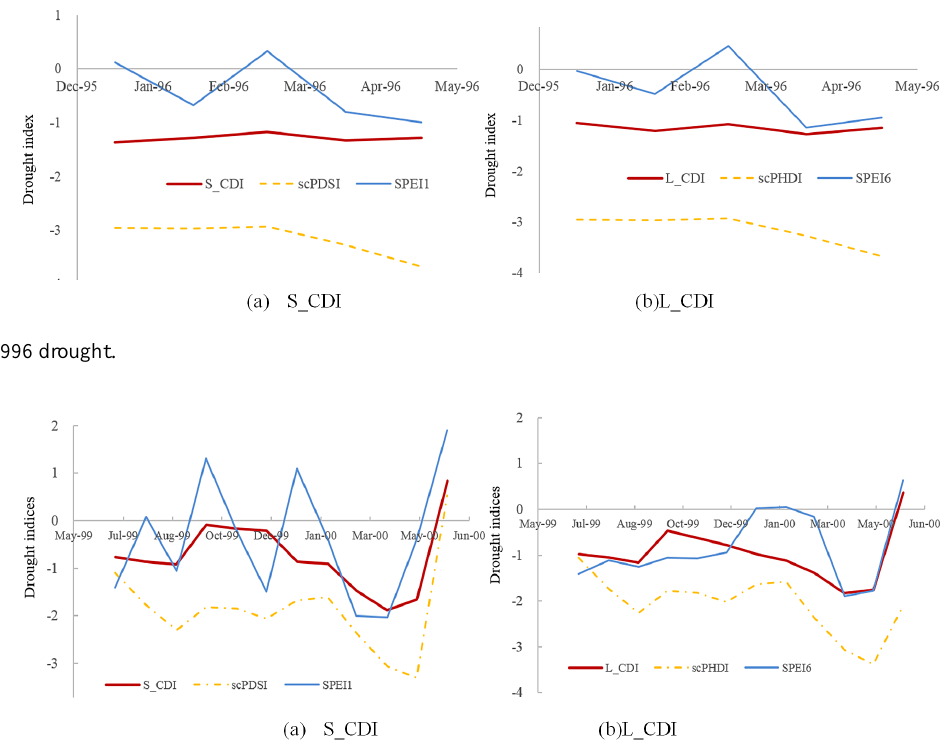
Figure 5. The 2000